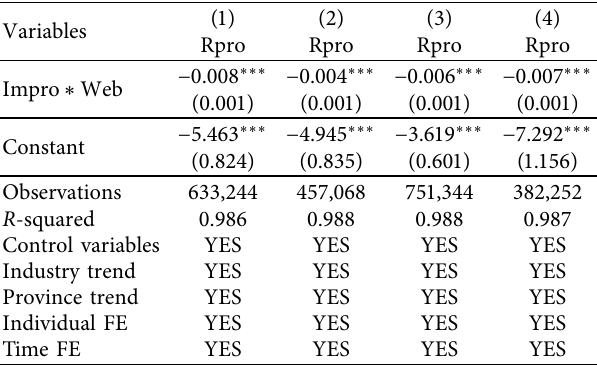
Table 10: Evidence of enterprises’ acquisition of tax avoidance